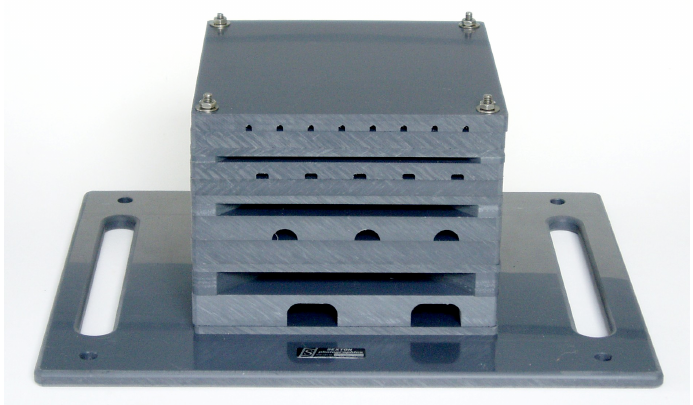
Figure 2. Picture of an Autonomous Reef Monitoring Structure (ARMS) before deployment in French Frigate